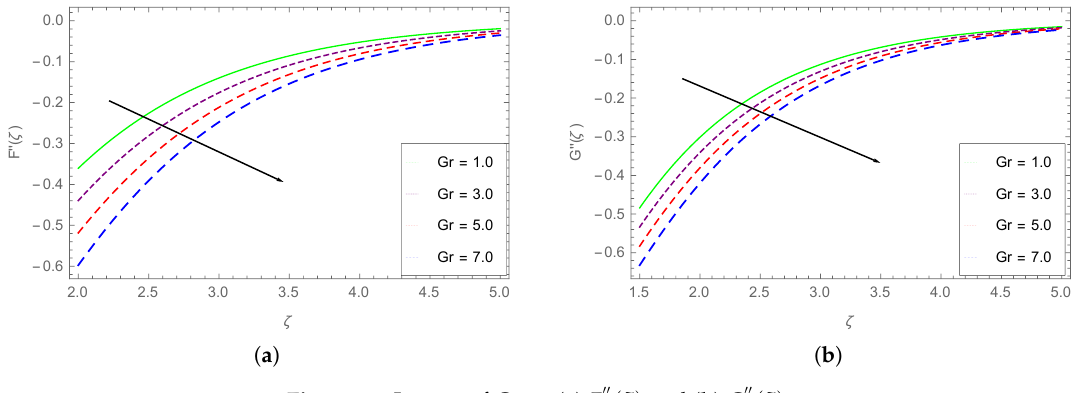
Figure 12. Impact of Gr on ( a ) F (cid:48)(cid:48) ( ζ ) and ( b ) G (cid:48)(cid:48) ( ζ )